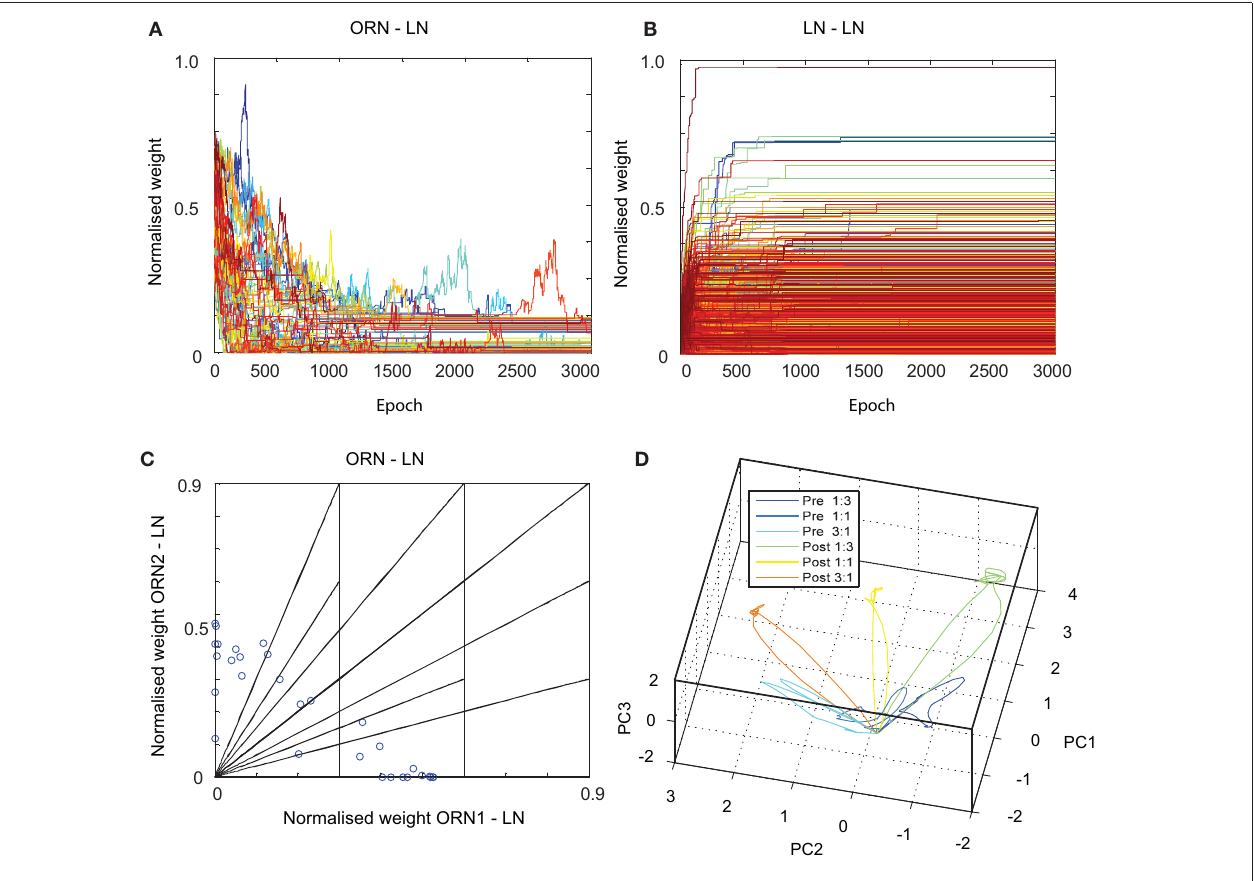
FIGURE 5 | Results of spike timing-dependent plasticity (STDP) applied to (A) ORN-LN and (B) LN-LN connections in the MGC AL neuronal model. Adapted weights of both connection types are shown to converge from an initial randomized state to stable asymptotic values over many epochs. (C) Normalized synaptic weights of ORN-LN connections show that